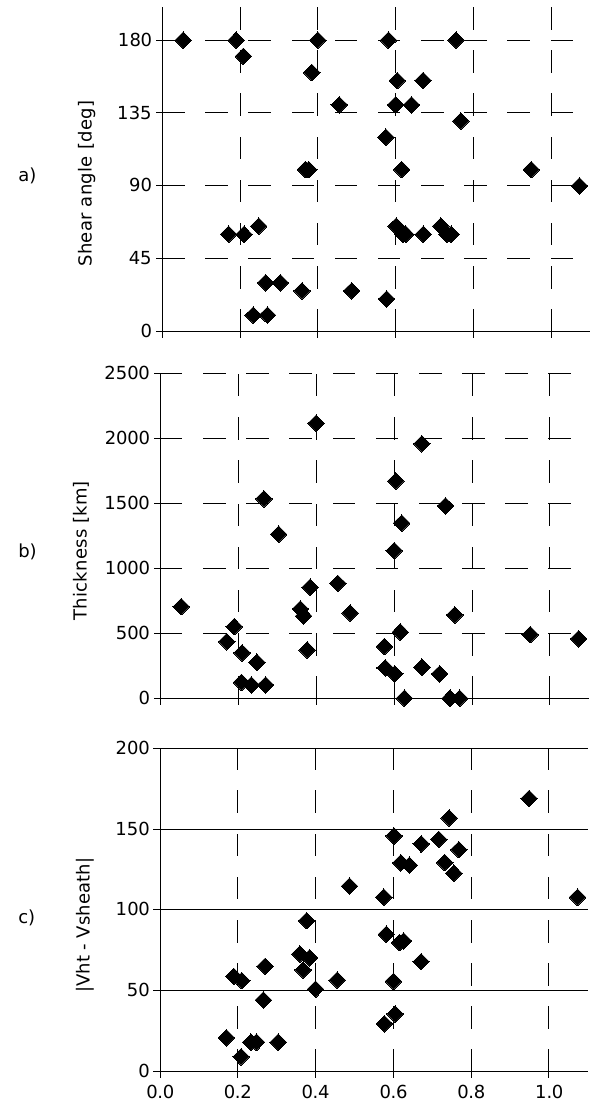
Fig. 14. Magnitude of the magnetic shear ( a ) , magnetopause thick- ness ( b ) , and magnitude of the velocity residue ( V msh − V HT ) ( c ) , plotted versus the magnitude of the Wal´en relation slope, for all cases where the correlation coefficient magnitude exceeds 0.85. While there is no correlation of the Wal´en slope with either mag- netic shear or magnetopause thickness, there is a clear correlation with the difference between magnetosheath and deHoffmann-Teller velocities, indicating that magnetic coupling increases with increas- ing Wal´en